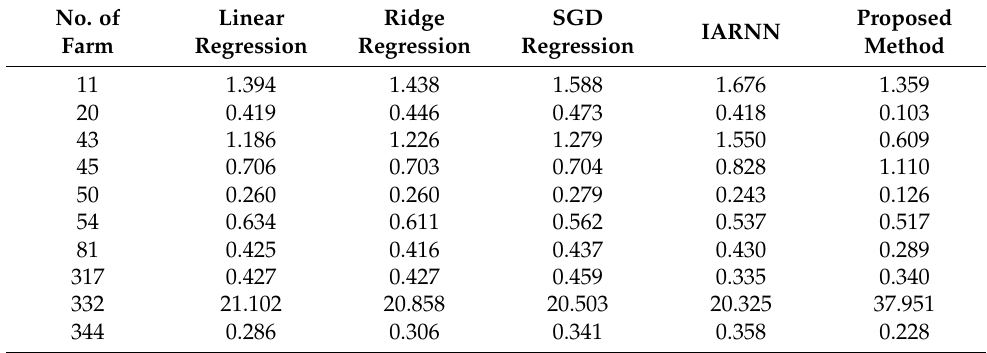
Table 4. Mean square error for several time series data analysis